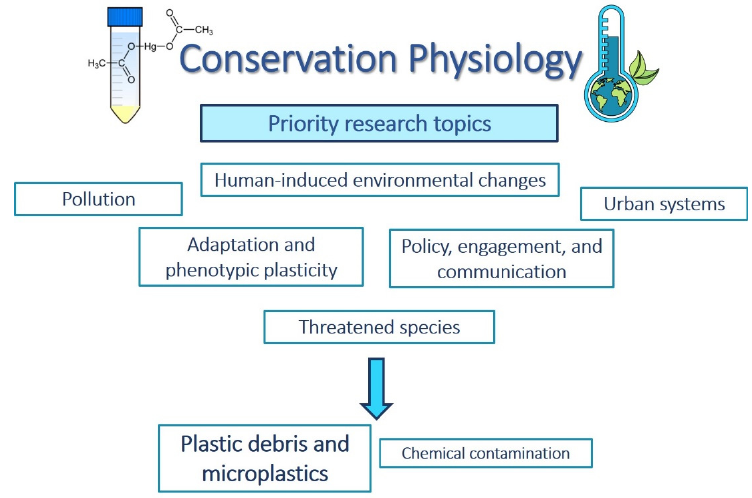
Figure 2. Research priority topics on climate change and ocean contamination according to Conser- vation Physiology experts (adapted from [85]).